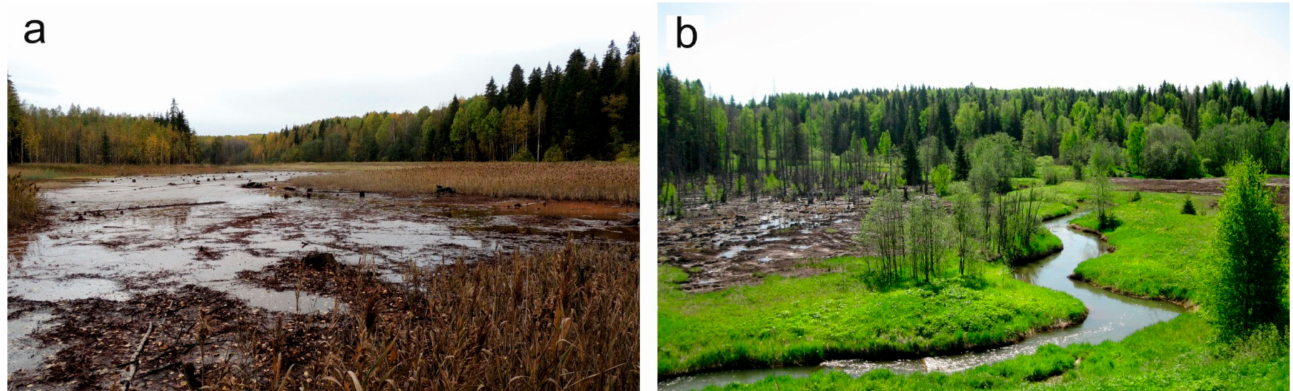
Figure 8. Different stages of ecosystem transformation to marsh: ( a ) a salt marsh forming after salt tailing pile construction; ( b ) seepage areas in the river valley with bare